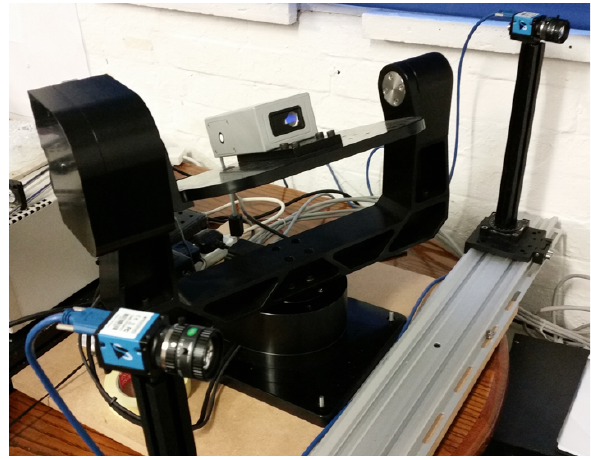
Figure 1 Custom 3D imaging system including scanning LIDAR and stereo camera pair.